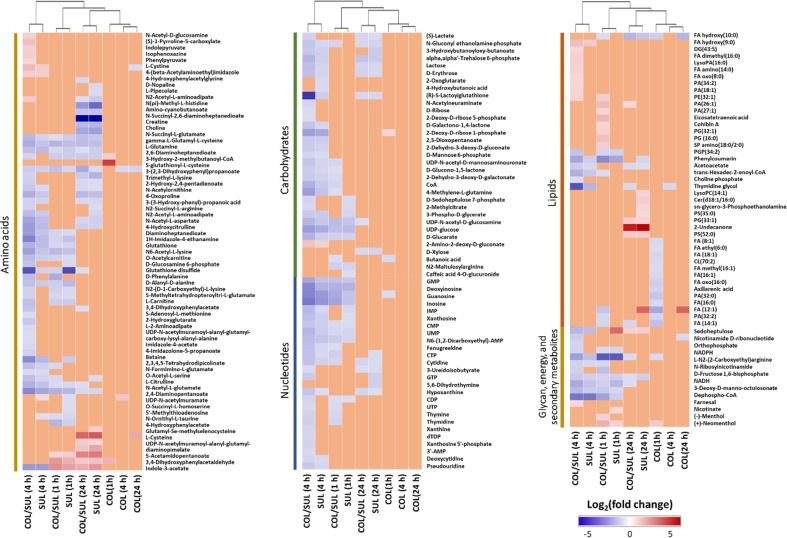
Clustered heat map profiles of the relative abundance for significantly affected metabolites in A. baumannii AB090342. Metabolites are grouped into different classes: amino acids, carbohydrates, lipids, nucleotides, glycan, energy, and secondary metabolites. The colors indicate the relative abundance of significantly affected metabolites by different treatments [colistin alone (COL), sulbactam alone (SUL), and the combination (COL/SUL)] at 1, 4, and 24 h, compared with the untreated control samples. Blue = significant decrease (log2FC ≤ −1), red = significant increase (log2FC ≥ 1), and orange = not significant.